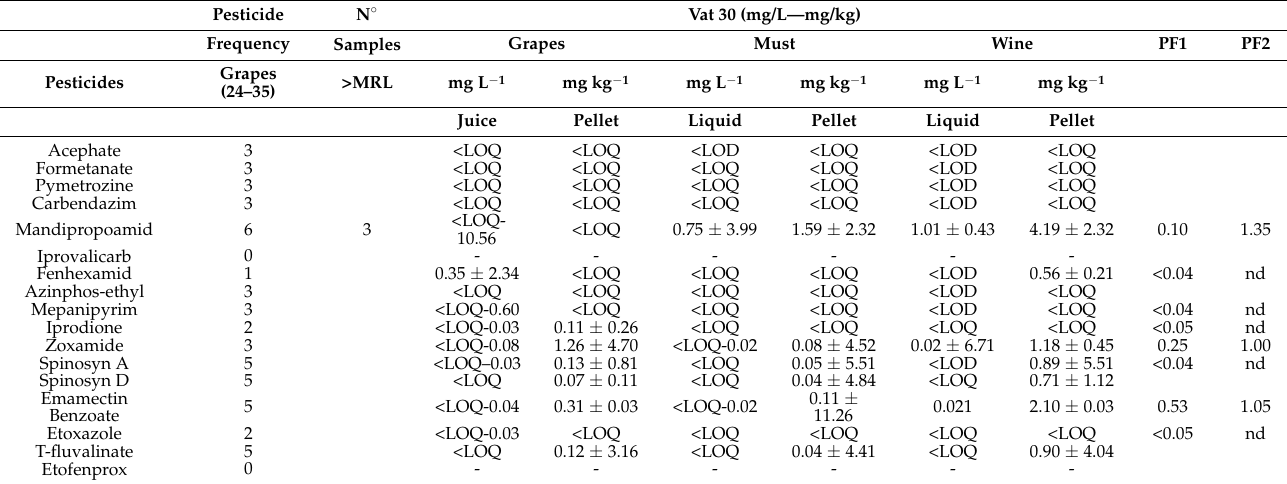
Table 3. Pesticide residues concentration in grape juice, must, and wine from 24–35 samples. Pesticide N ◦ Vat 30 (mg/L—mg/kg) Frequency Samples Grapes